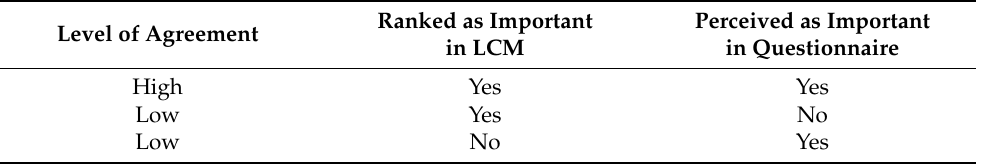
Table 3. Classes of agreement of a driver in geospatial and land-users approach. Level of Agreement